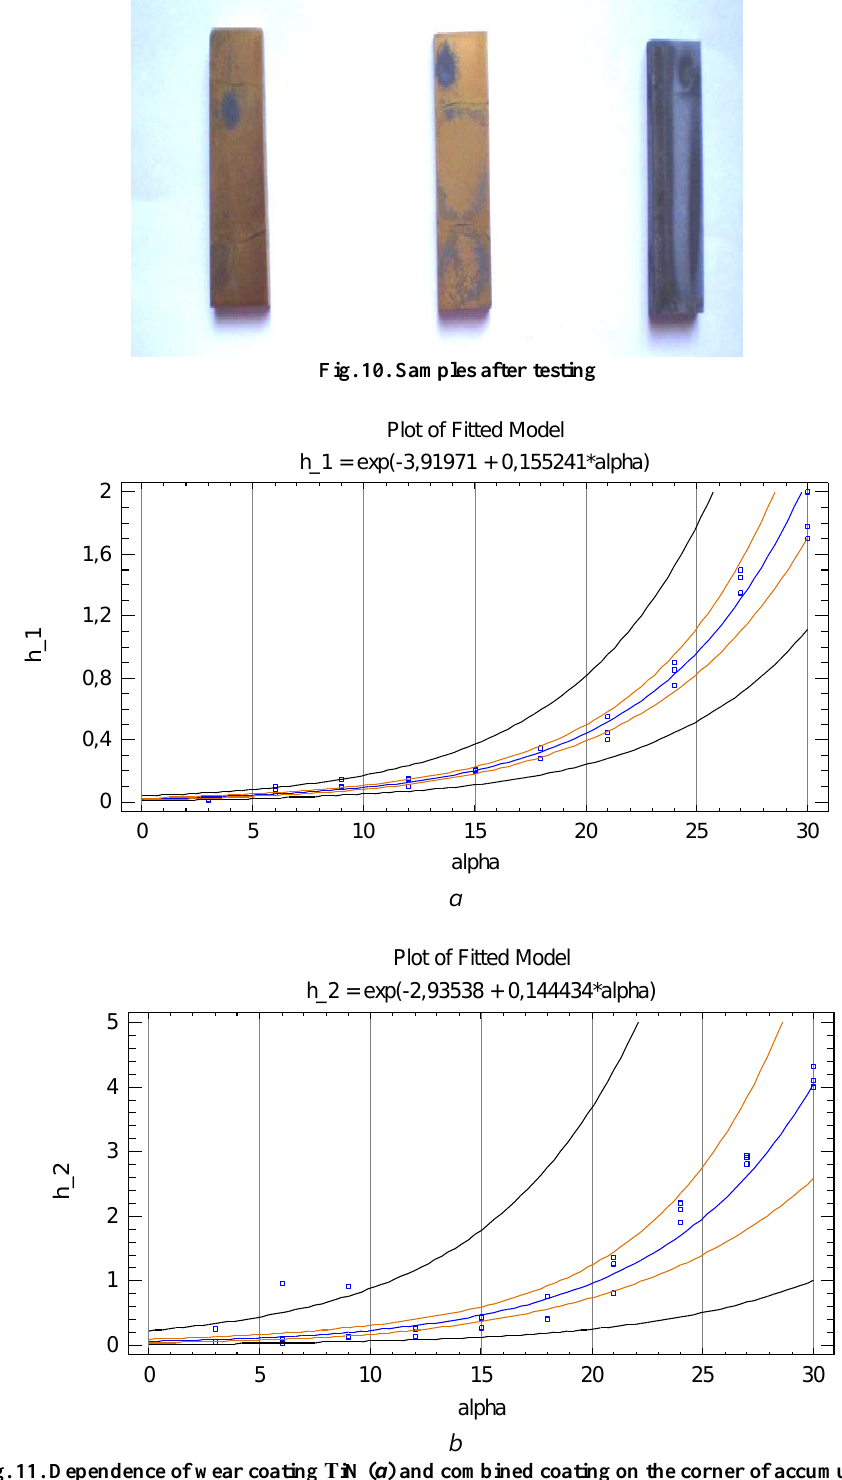
Fig. 11. Dependence of wear coating ТiN ( a ) and combined coating on the corner of accumulating ( b